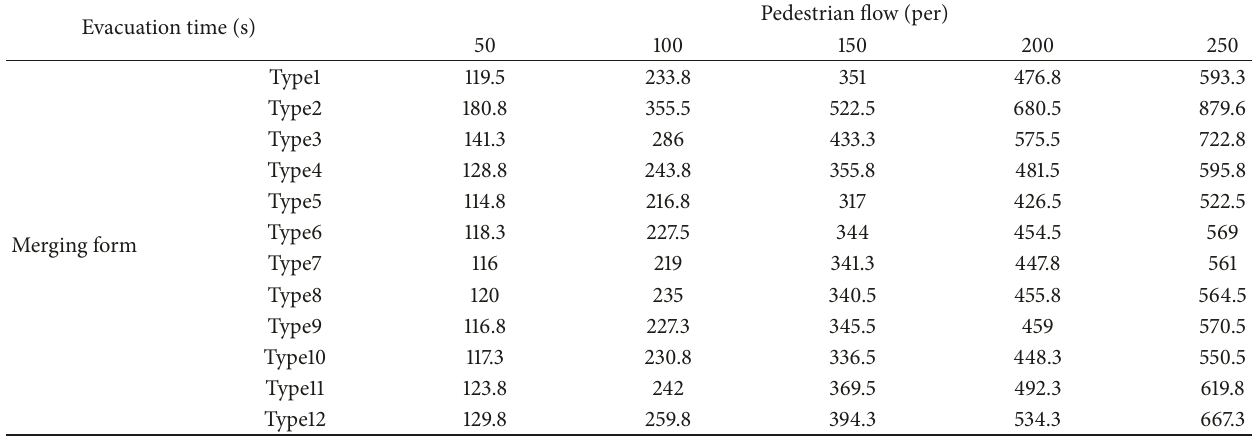
Table 1: The evacuation time of different pedestrian flow rate.